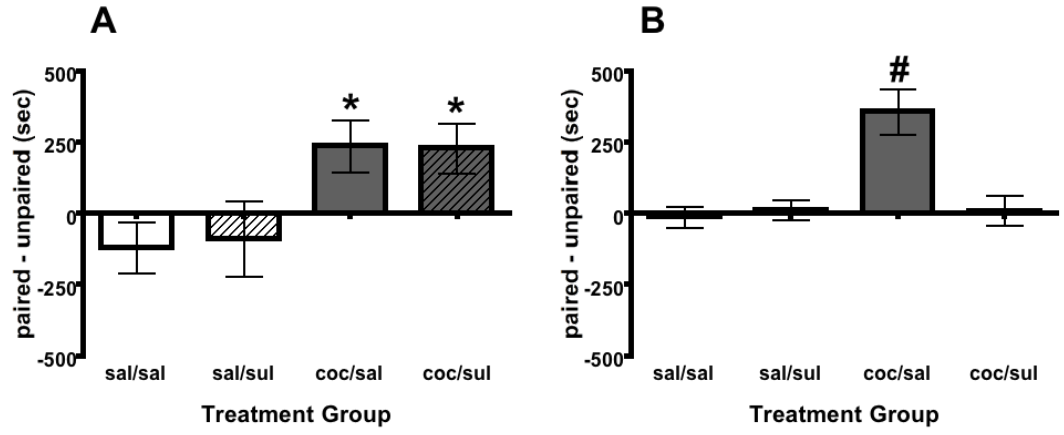
Figure 4. Effects of Intra-NAcc or Intra-VTA Sulpiride on Reinstatement. ( A ) Adult rats with a history of early cocaine exposure showed cocaine induced reinstatement of cocaine place conditioning (grey bars; indicated by *). There was no effect of intra-NAcc sulpiride on cocaine-induced reinstatement of cocaine place conditioning (grey striped bars; indicated by *). Sample sizes = 8 sal/sal; 7 sal/sul; 8 coc/sal; 8 coc/sul. ( B ) Adult rats with conditioning (grey bars; indicated by # ). Intra-VTA sulpiride blocked cocaine-induced reinstatement of cocaine place conditioning (grey striped bars). Sample sizes = 8 sal/sal; 8 sal/sul; 8 coc/sal; 8 coc/sul. NAcc = nucleus accumbens, VTA = ventral tegmental area, sal = saline, sul = sulpiride and coc = cocaine. All bars denote means and